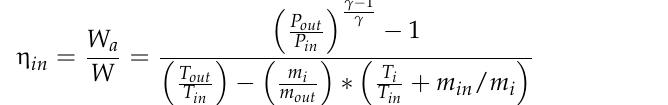
Figure 4. Comparison of computed and measured adiabatic efficiency characteristic.